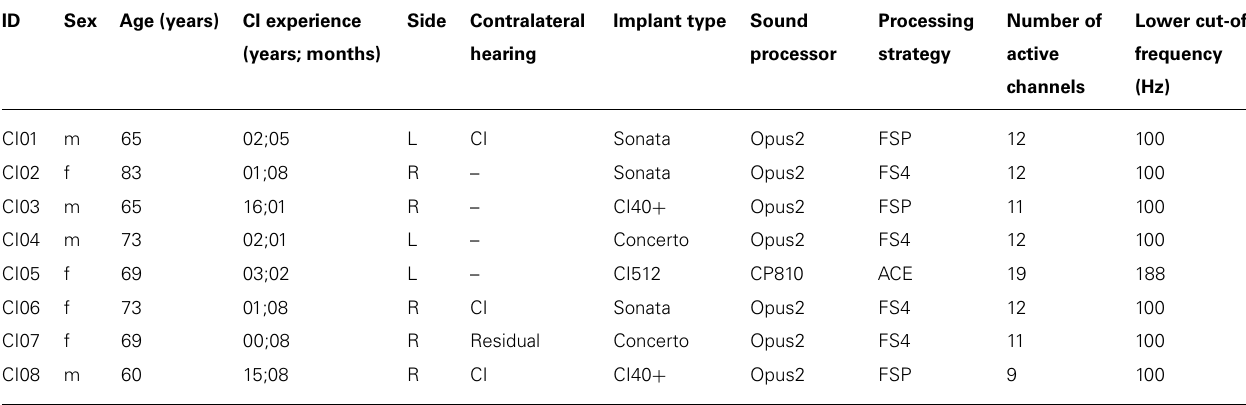
Table 1 | Demographic data of the CI users participating in the experiment. ID